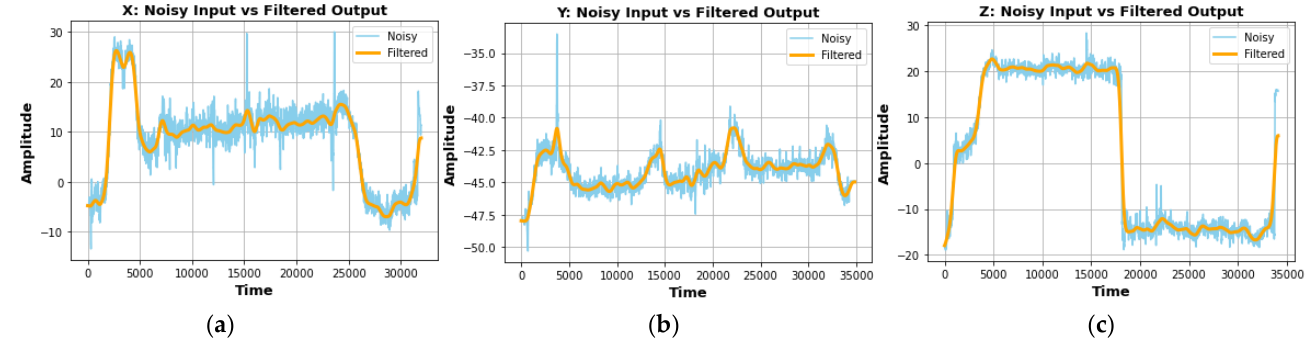
Figure 3. Signal denoising using second-order Chebyshev type-I filter with a cutoff frequency equal to 0.001. ( a ) Real-World HAR magnetometer x-channel, ( b ) Real-World HAR magnetometer y-channel, and ( c ) Real-World HAR magnetometer z-channel.